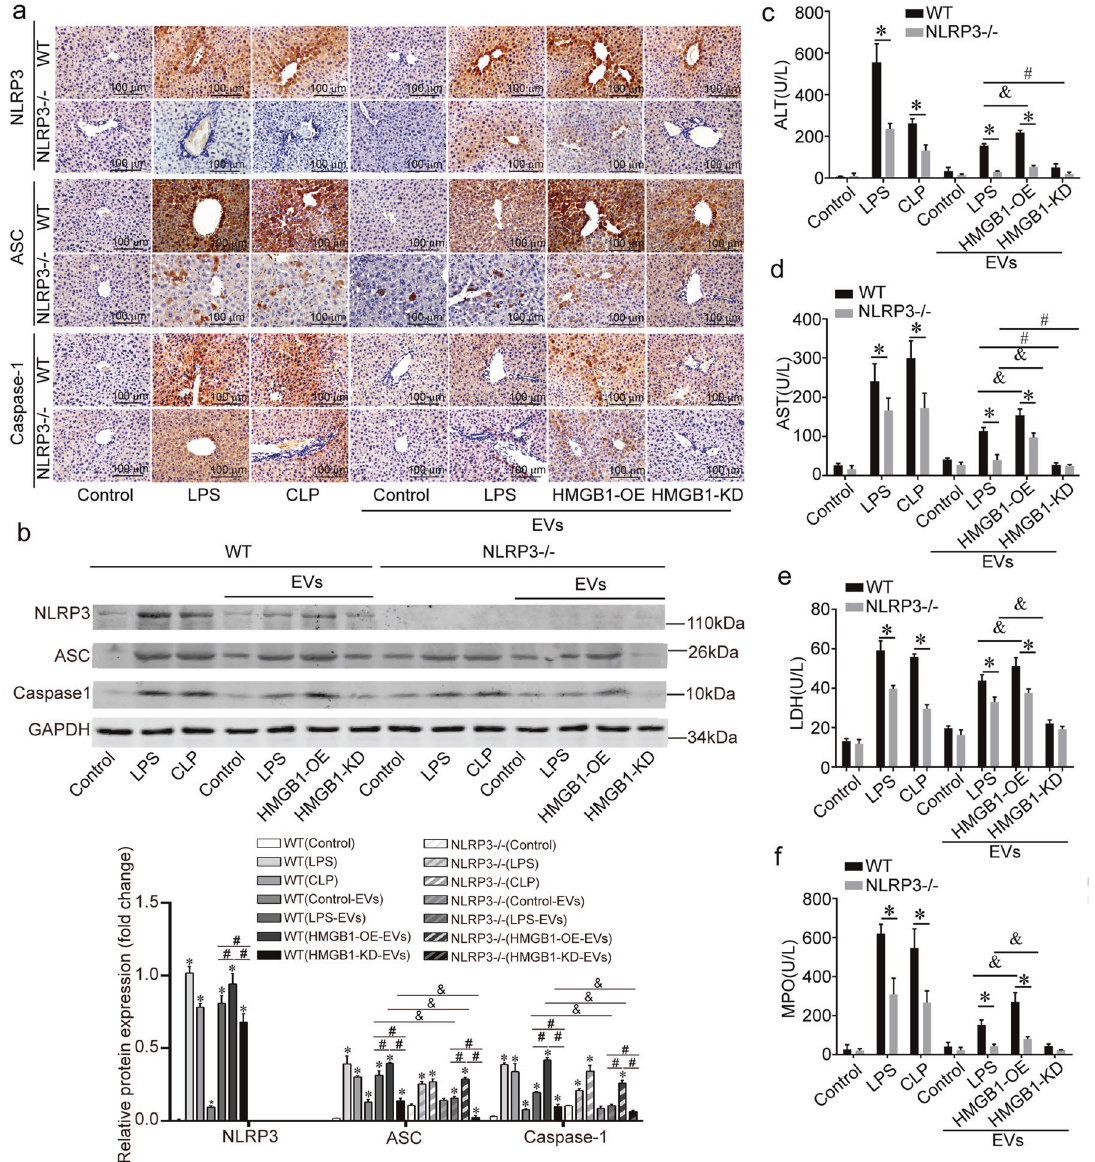
Fig. 7 HMGB1 + EVs cause liver damage and activate NLRP3 in fl ammasomes in the liver. a EVs were collected from Raw264.7 (control, HMGB1-Overexpressing and HMGB1-Knockdown) were injected into WT and NLRP3 − / − mice. The LPS or CLP surgery models served as the sepsis positive models. Expression of NLRP3, ASC and Caspase-1 was evaluated; scale bar = 100 μ m. n = 5 mice per group. b The expression levels of NLRP3/ASC/Caspase-1 were analyzed by immunoblotting. Data are expressed as means ± sd. * for p < 0.01 vs control group. # for p < 0 . 05; & for p < 0.05. c – f Serum ALT, AST, LDH and MPO levels. Data are expressed as means ± sd. * for p < 0.01. & for p < 0.05; # for p < 0.01. n = 5 mice per